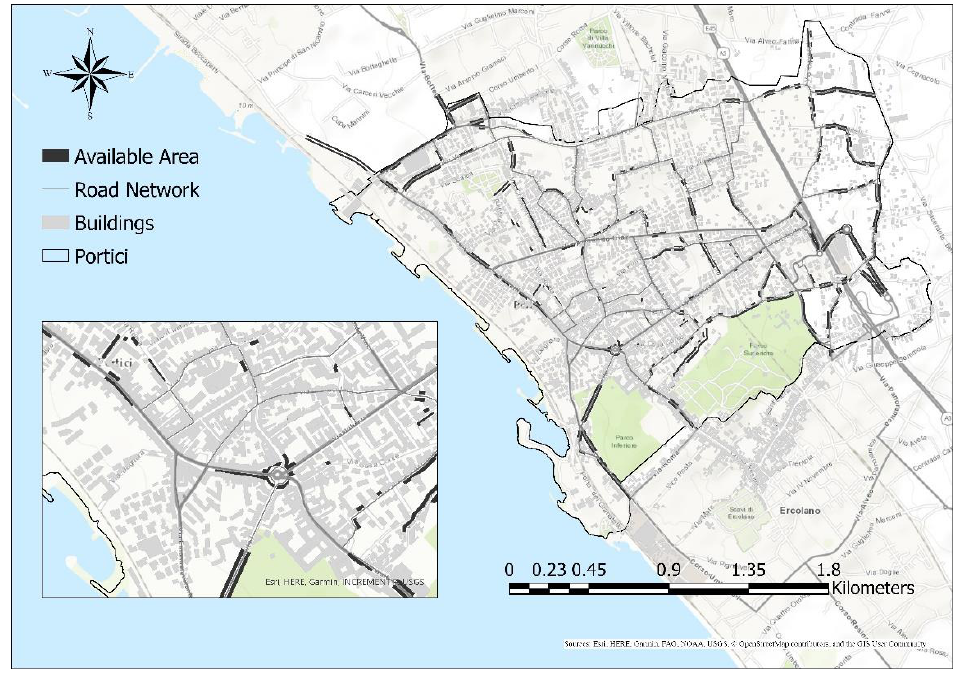
Figure 8. Site availability map for networks of low-cost traffic-orientated stations for air pollutants monitoring across the city of Portici.